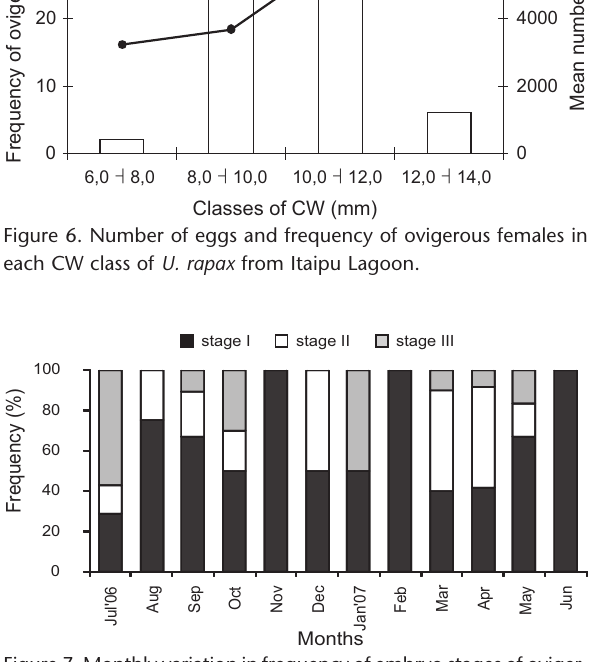
Figure 7. Monthly variation in frequency of embryo stages of oviger- ous females of U. rapax from Itaipu Lagoon.